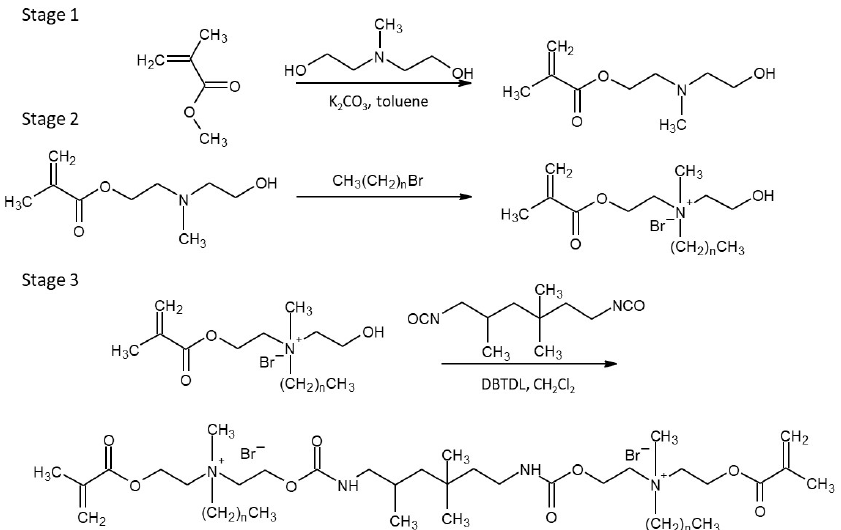
Figure 1. The synthesis route and chemical structure of the QAUDMA resins used in this study ( n = 7–17). Stage 1—Synthesis of HAMA, Stage 2—Synthesis of QAHAMAS, Stage 3—Synthesis of QAUDMAs.